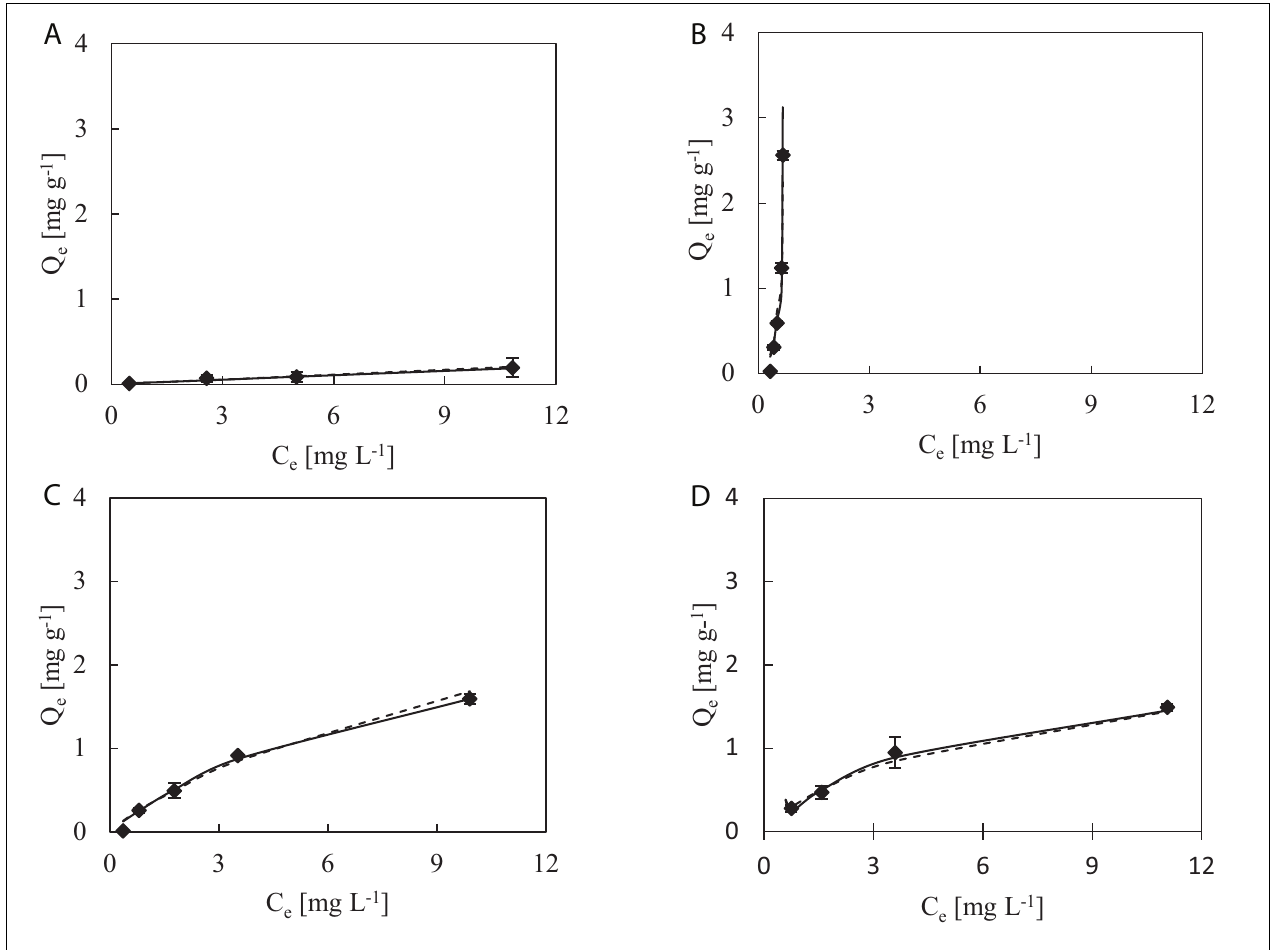
FIGURE 3 | Equilibrium adsorption capacity ( Q e ; mg/g) as function of equilibrium concentration of PO 4 -P ( C e ; mg/L) as modeled using Langmuir (------) and Freundlich (————–) isotherms, compared to the measured adsorption capacities ( (cid:7) ) in (A) untreated biochar (UBC), (B) CaO-impregnated biochar